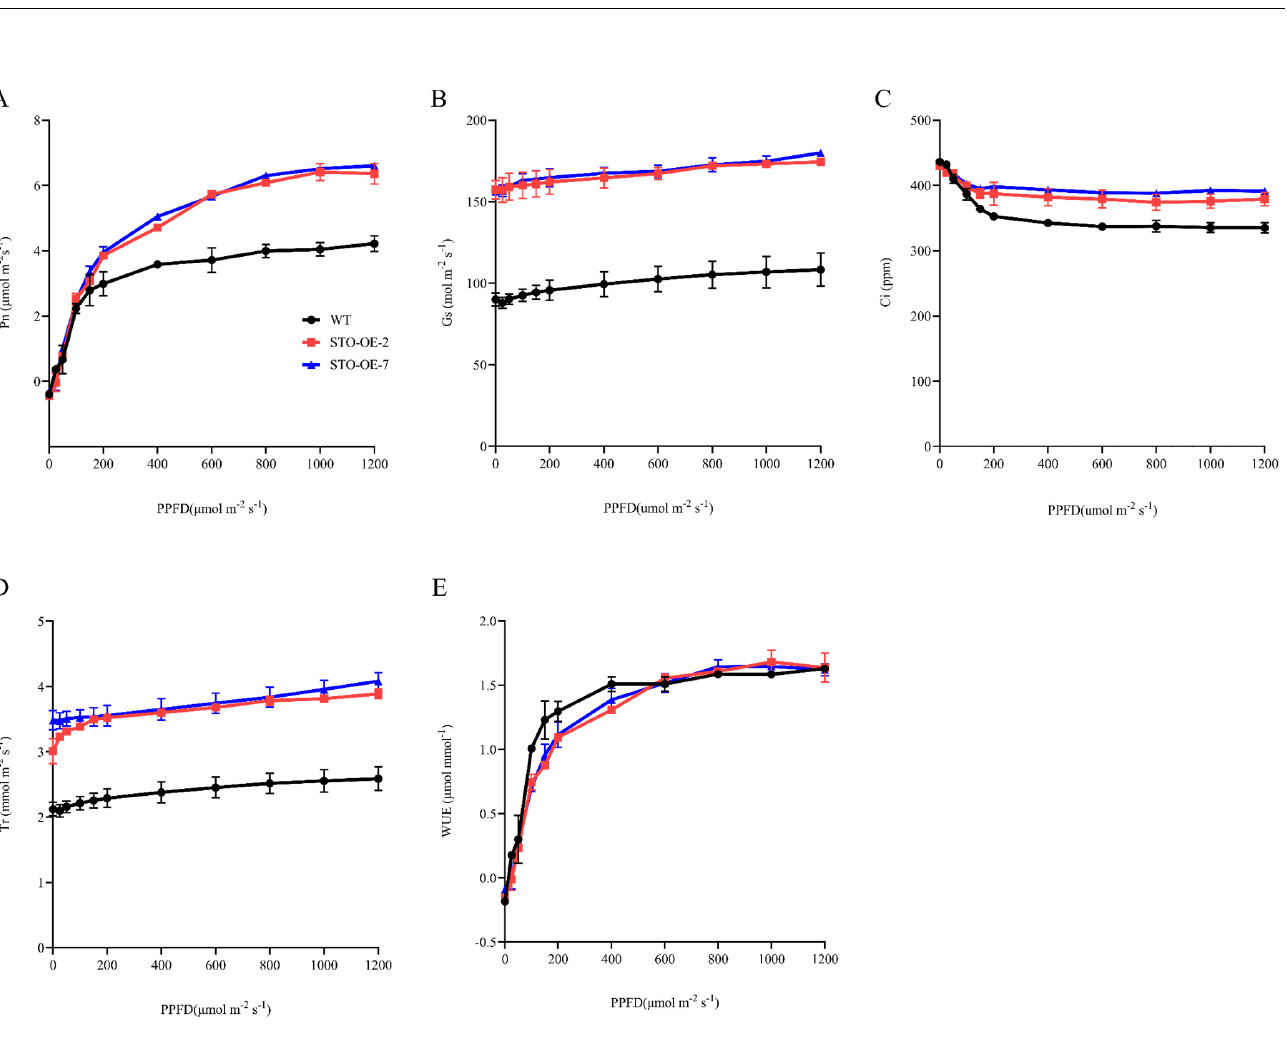
Figure 5. Overexpression of PagSTOMAGEN enhances photosynthesis in poplar. Light-response curves were obtained for STO-OE and WT. ( A ) Net photosynthetic rate ( Pn )–light curve. ( B ) Stomatal conductance ( Gs )–light curve. ( C ) Intracellular CO 2 concentration ( Ci )–light curve. ( D ) Transpiration rate ( Tr )–light curve. ( E ) Water-use efficiency ( WUE )–light curve. Error bars are indicated by the SD of three biological replicates.